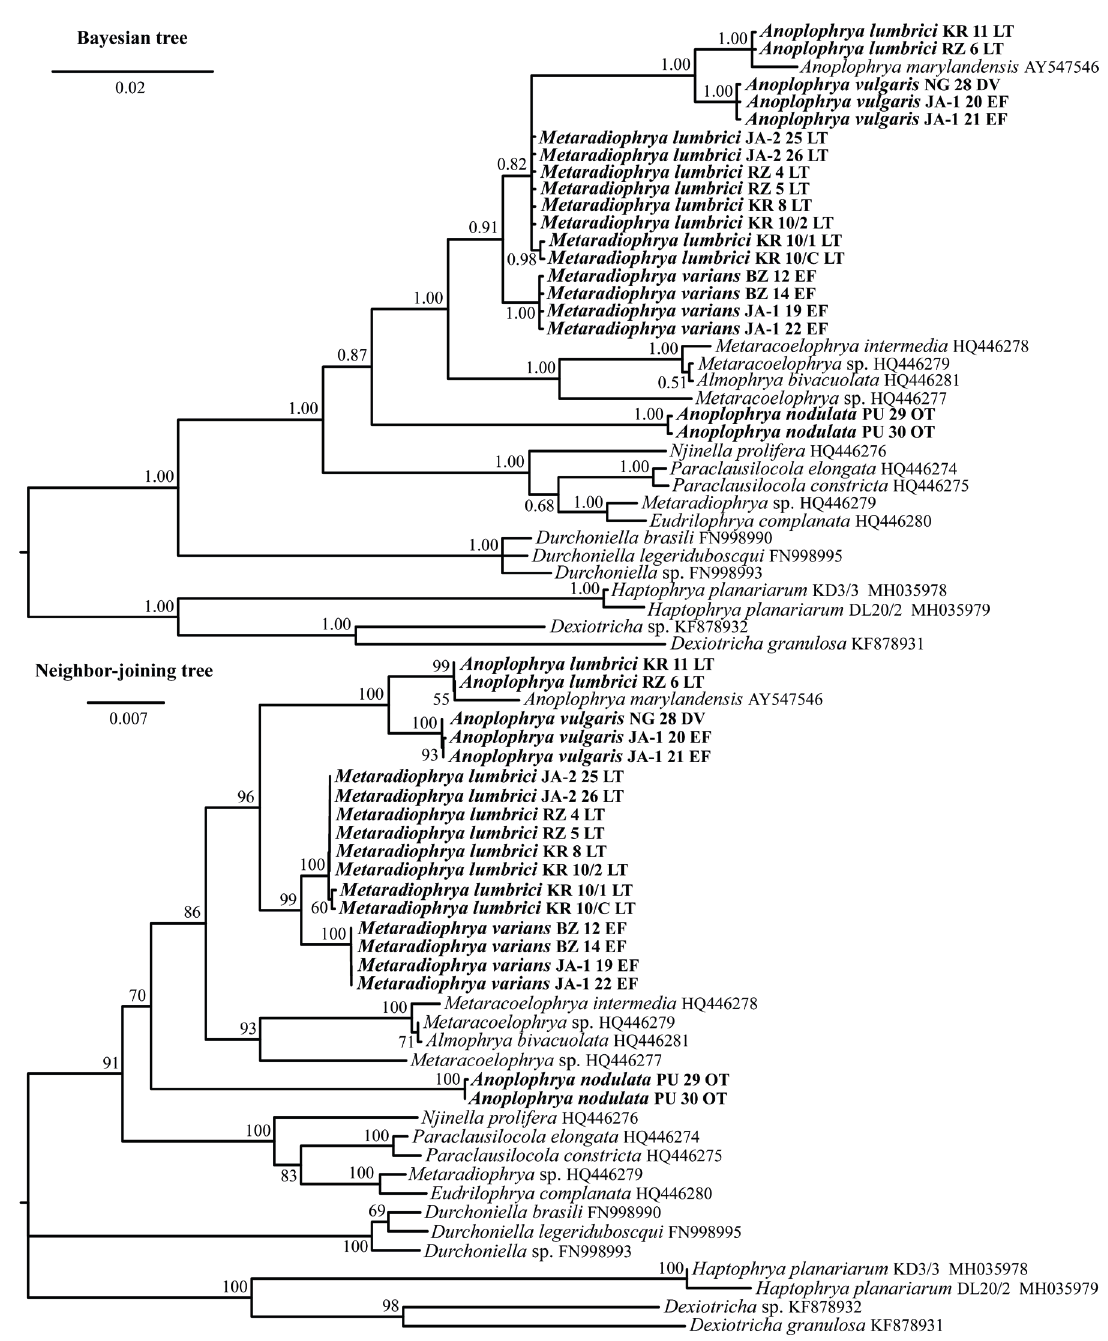
Fig. 15. Small subunit rRNA gene phylogenetic trees showing systematic positions of astome ciliates isolated from lumbricid earthworms. Posterior probabilities were mapped onto the 50%-majority rule Bayesian consensus tree (upper panel) and bootstrap values onto the 50%-majority rule neighbor-joining tree (lower panel). Sequences in bold face were obtained during this study. Note that there is a conflict between the Bayesian and the neighbor-joining tree in the position of specimens of Metaradiophrya Jankowski, 2007. However, according to tree topology tests, the branching pattern of the Bayesian tree is not significantly better than that of the neighbor-joining tree. The scale bar denotes fraction of